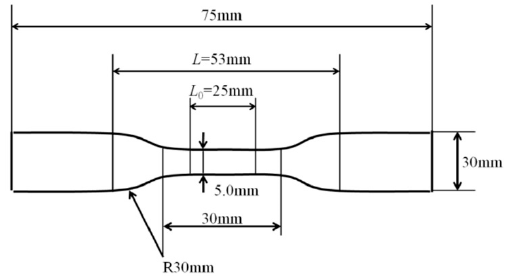
Figure 4. Dimensions of the sample used for tensile test.